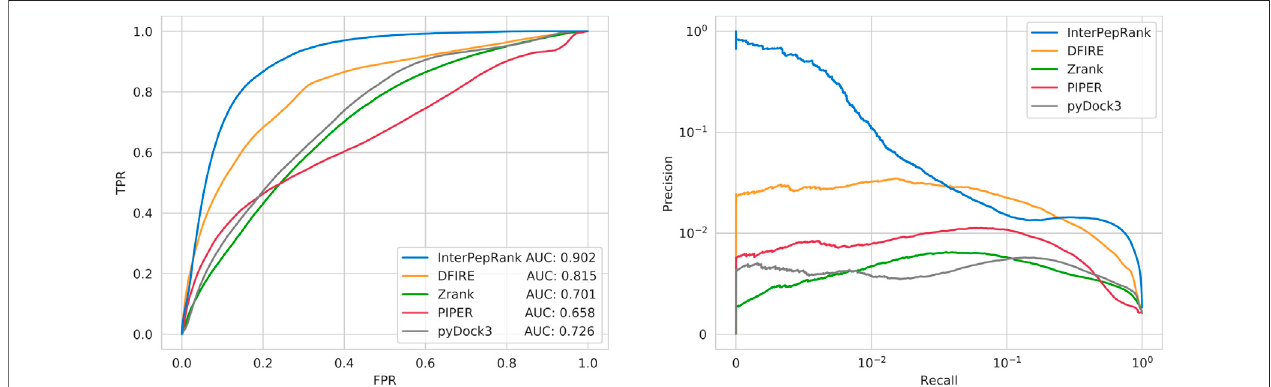
FIGURE 4 | ROC-curves for using the method scores to separate low-LRMSD decoys from other decoys (left) , and Precision-Recall curves for the same thing (right). Notethatthe scaleoftheright curve islogarithmic, whichisnecessarybecause ofthelargeclass-imbalance ofthe problem. Zrank, DFIRE, pyDock3,and PIPER are normalized by the total length of receptor and peptide. Analysis run only on the decoys from the Expanded Analysis set.